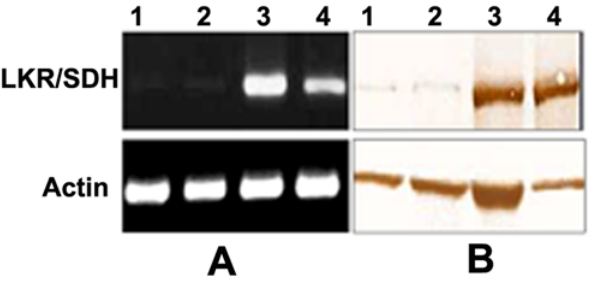
Figure 9. Effect of dsRNA treatment on LKR and SDH gene disruption. A. Reverse transcription PCR analysis. B. Western blotting analysis. LKR-, SDH- and Luc- dsRNAs and PBS were injected into the each group of female H. longicornis adults. The injected ticks (15 individuals for each group) were infested on rabbits, and ticks recovered after 4 days of feeding. Lane 1, LKR dsRNA-injected ticks; lane 2, SDH dsRNA-injected ticks; lane 3, PBS-injected ticks; lane 4, firefly gene of Luciferase (Luc) dsRNA-injected ticks.